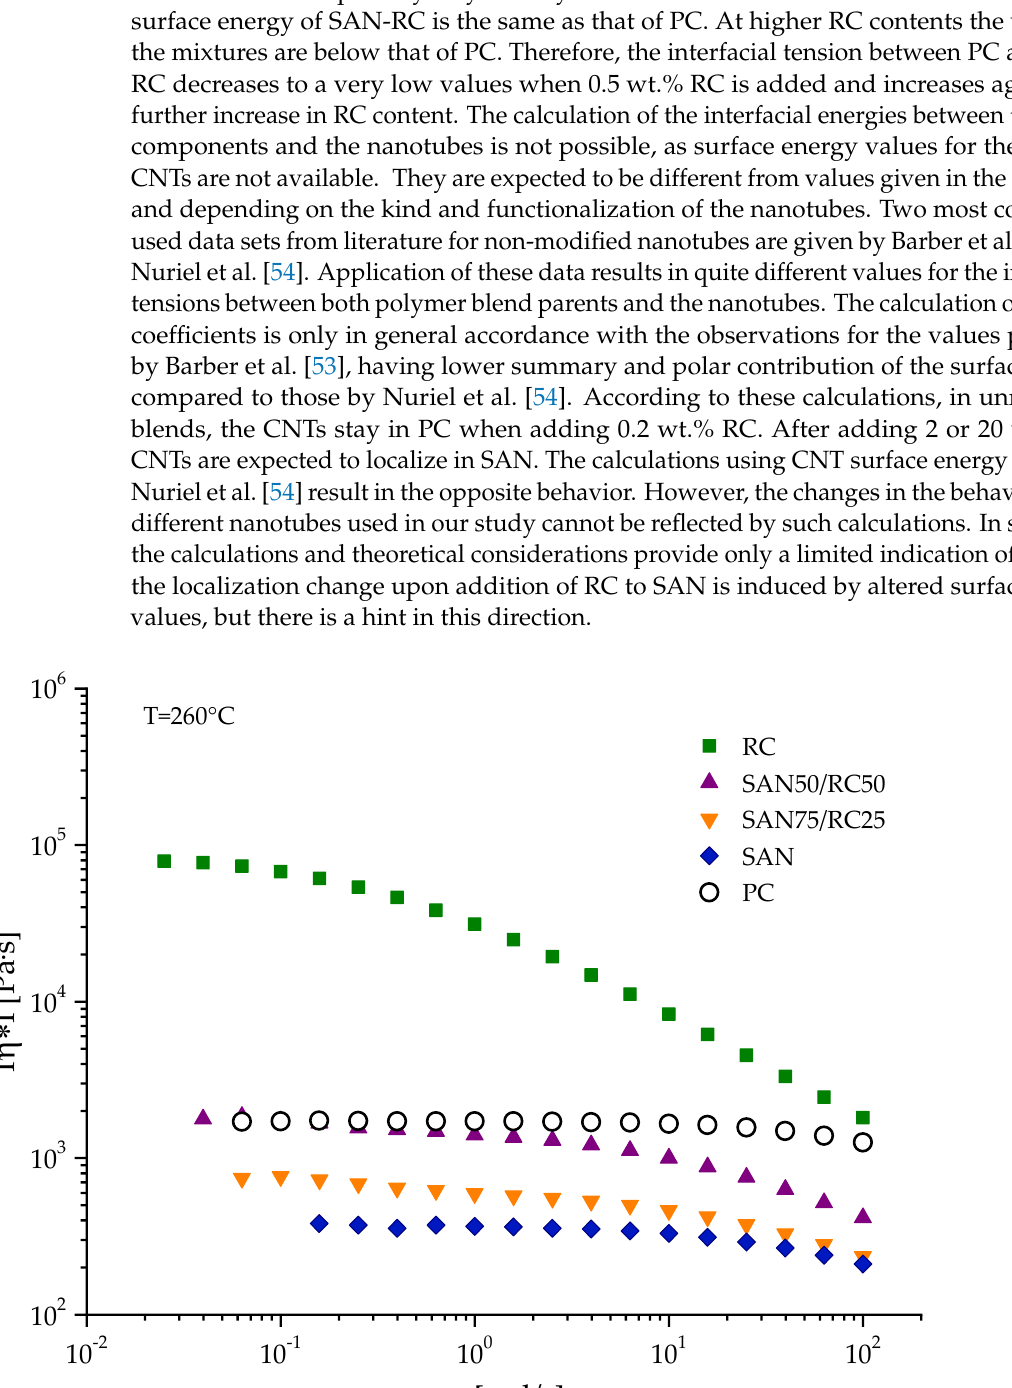
Table 1. Assignment of which blend component the various CNTs are localized in when 0.5 wt. % CNTs are added in a one-step melt blending process.